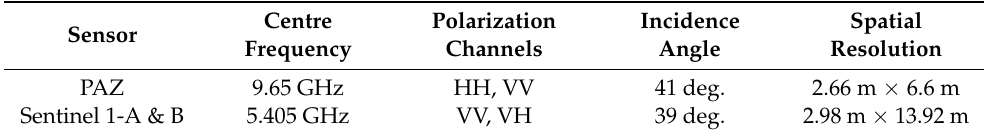
Table 2. Details of the input SAR images.